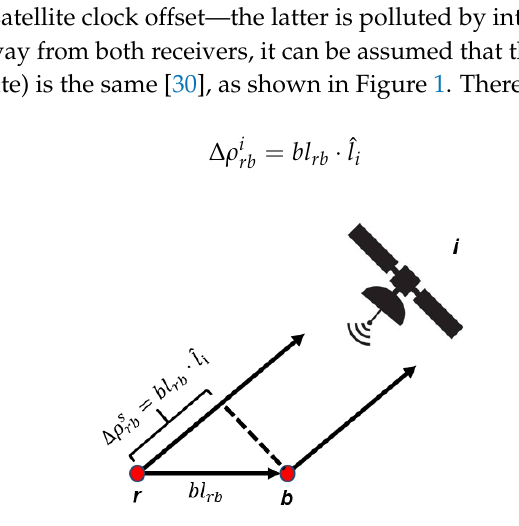
Figure 1. Graphical representation of the relationship between ∆ ρ i